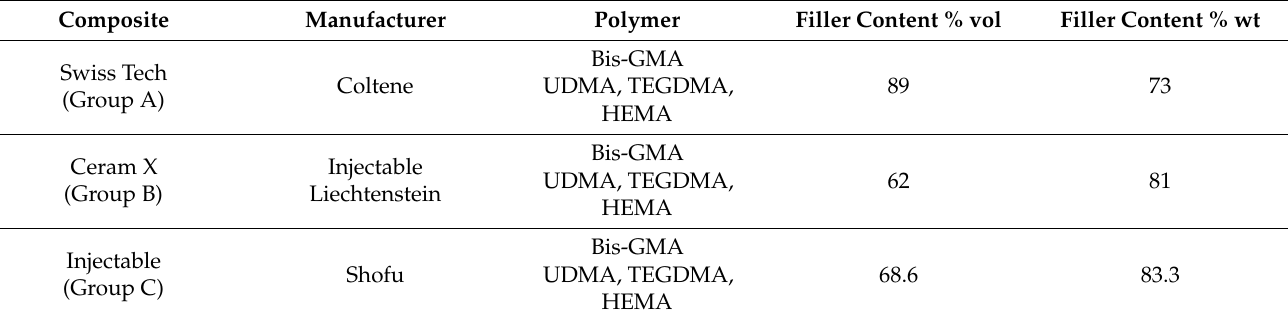
Table 1. Technical profiles of the composites tested in the current